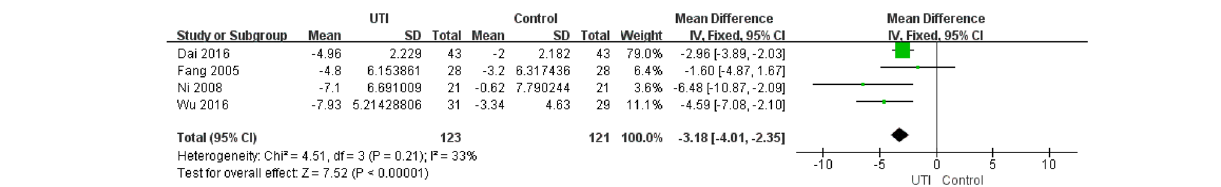
FIGURe 4 | Ulinastatin reduces the APACHE II score of sepsis patients.